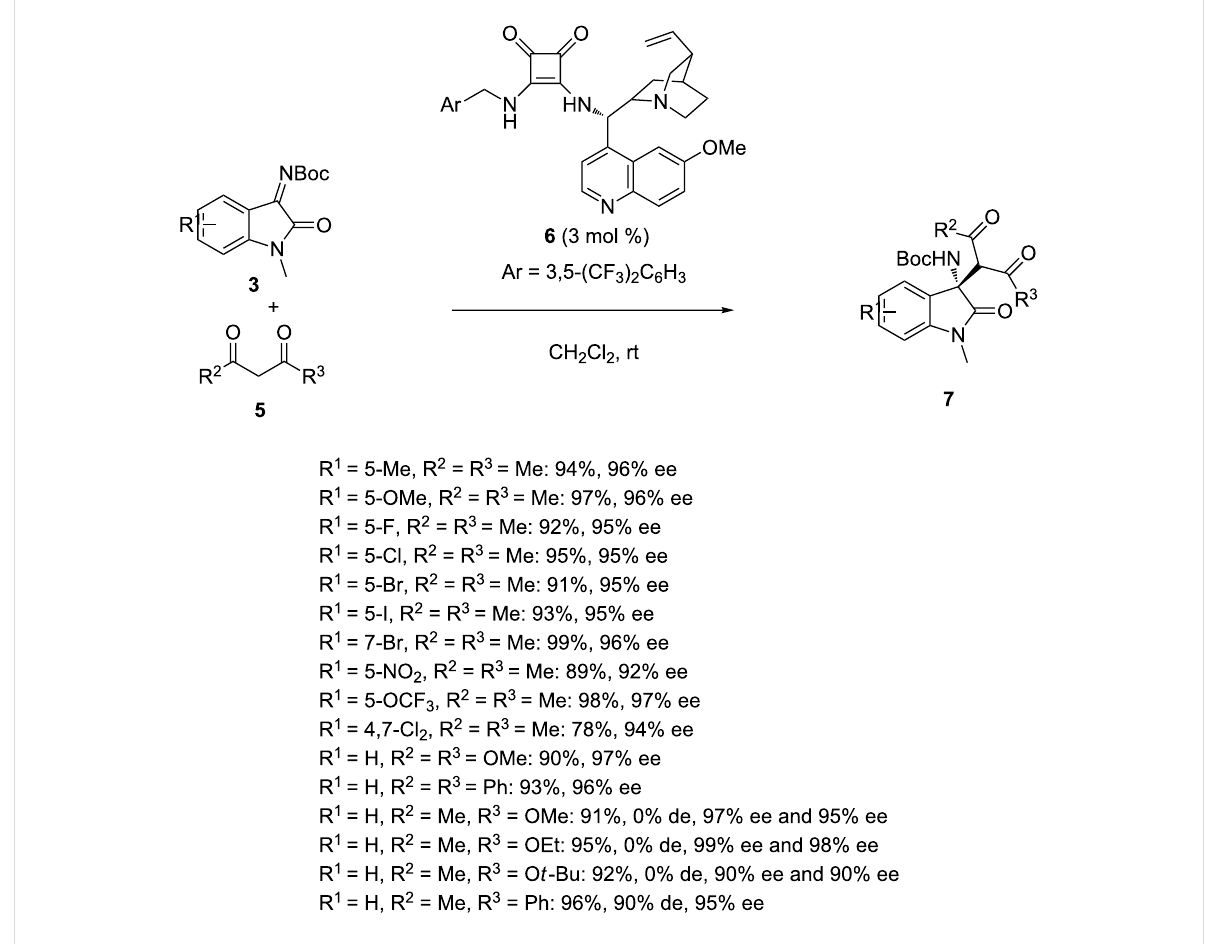
Scheme 2: Mannich reaction of N -Boc-isatin imines with 1,3-dicarbonyl compounds catalyzed by a cinchona alkaloid-derived squaramide.